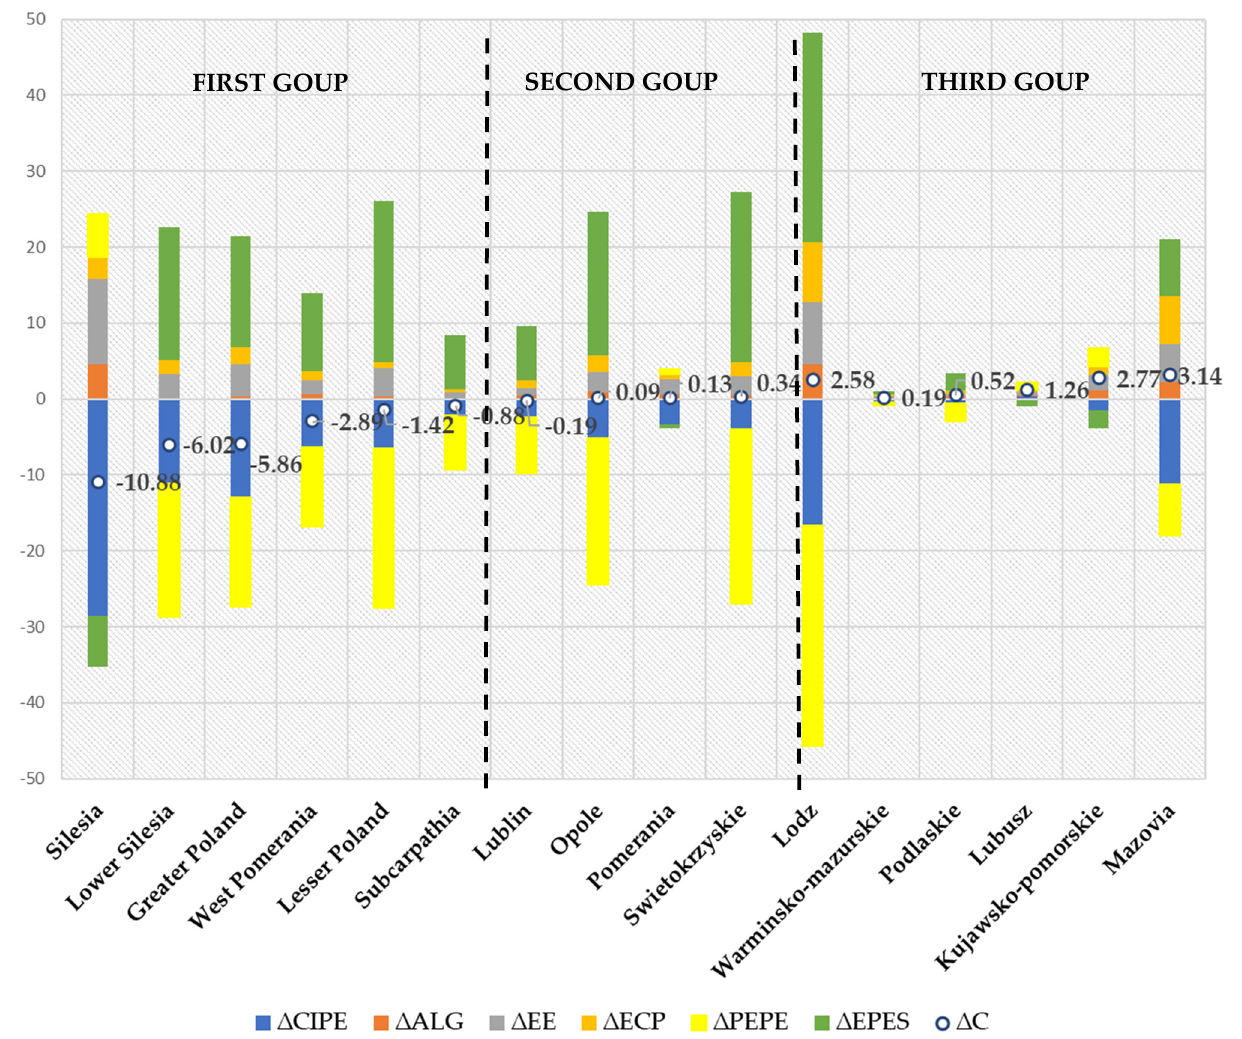
Figure 4. Temporal decomposition of cumulative absolute changes in CO 2 emissions in 16 Polish regions in 2010–2019 (in Mt). Source: own elaborations.